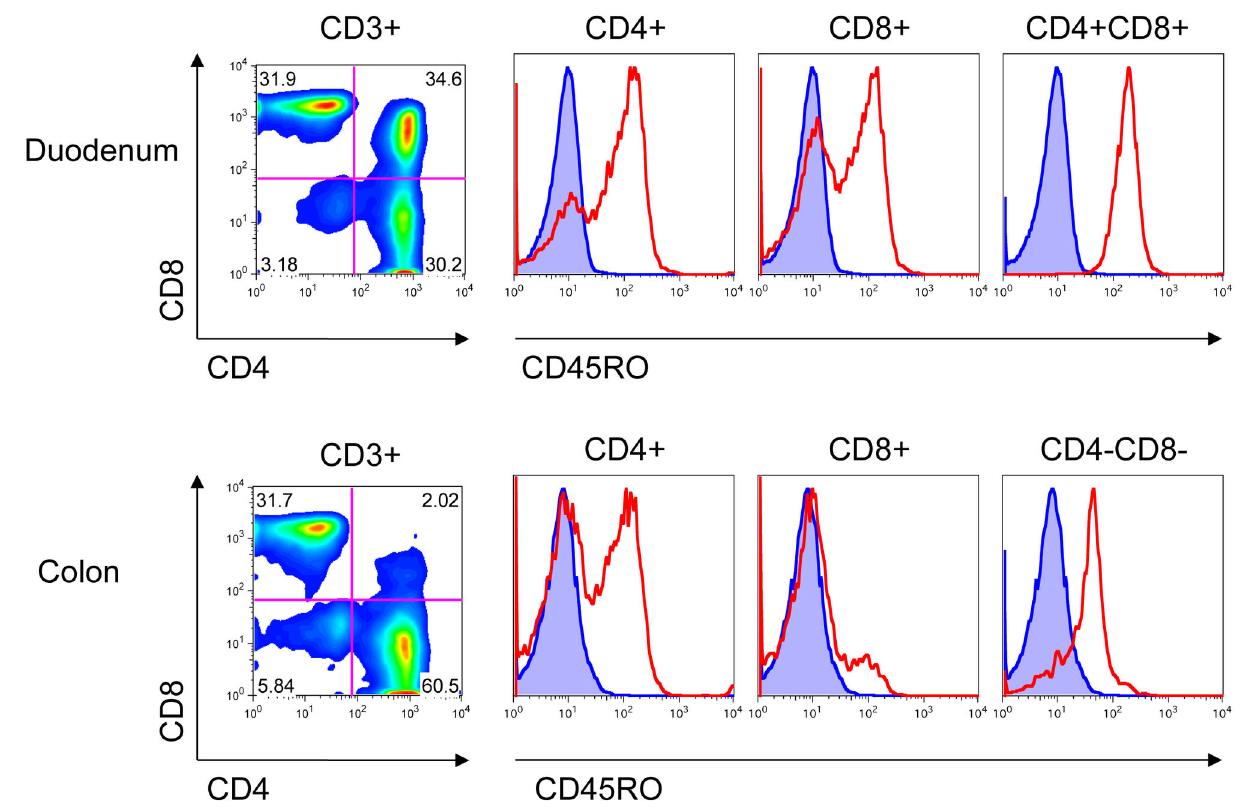
Figure 7. CD45RO expression on T-cells in the gut. Lymphocytes were isolated from GALT of colon and duodenum of a SHIV- infected pigtailed macaque at time of necropsy and stained with Abs to CD3, CD4, CD8, and CD45RO. Cells were analyzed by FACS. Lymphocytes were gated by light scatter, and then on CD3+ cells. Cells were further gated on CD4 and CD8. Expression of CD45RO is shown in red. Unstained cells are shown in blue. Data representative of n=5 macaques. doi: